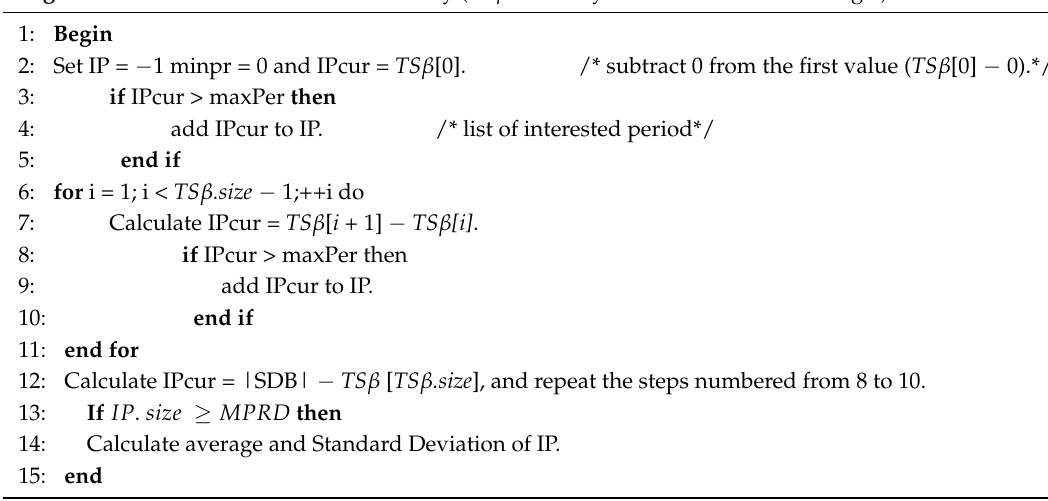
Figure 3. Prefix-tree and conditional tree construction with the PPFP-tree. ( a ) Prefix-tree for ‘ Bs4 ’ ( b ) Conditional tree for ‘ Bs4 ’ and ( c ) PPFP-tree after removing item ‘ Bs4’